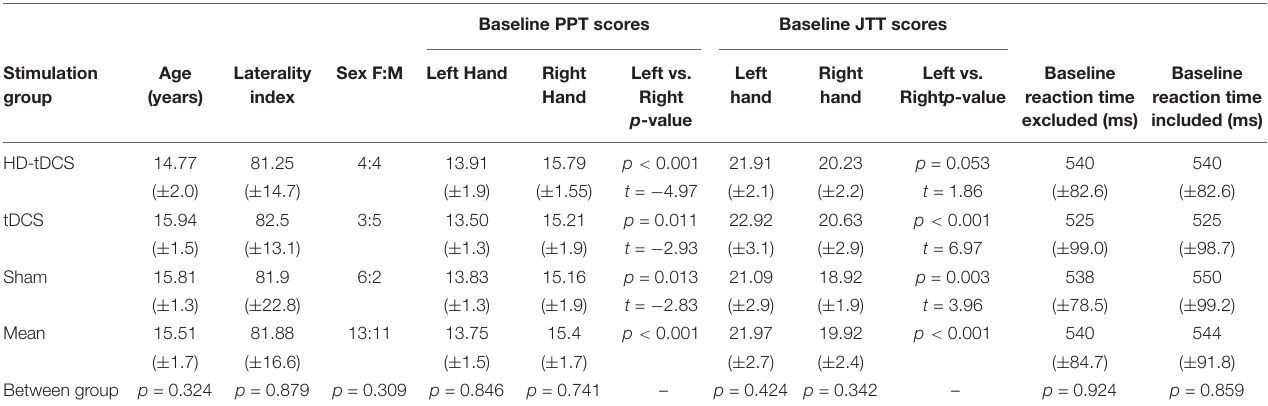
TABLE 1 | Participant demographics and baseline motor